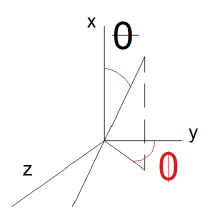
Figure 9. Analysis of cut